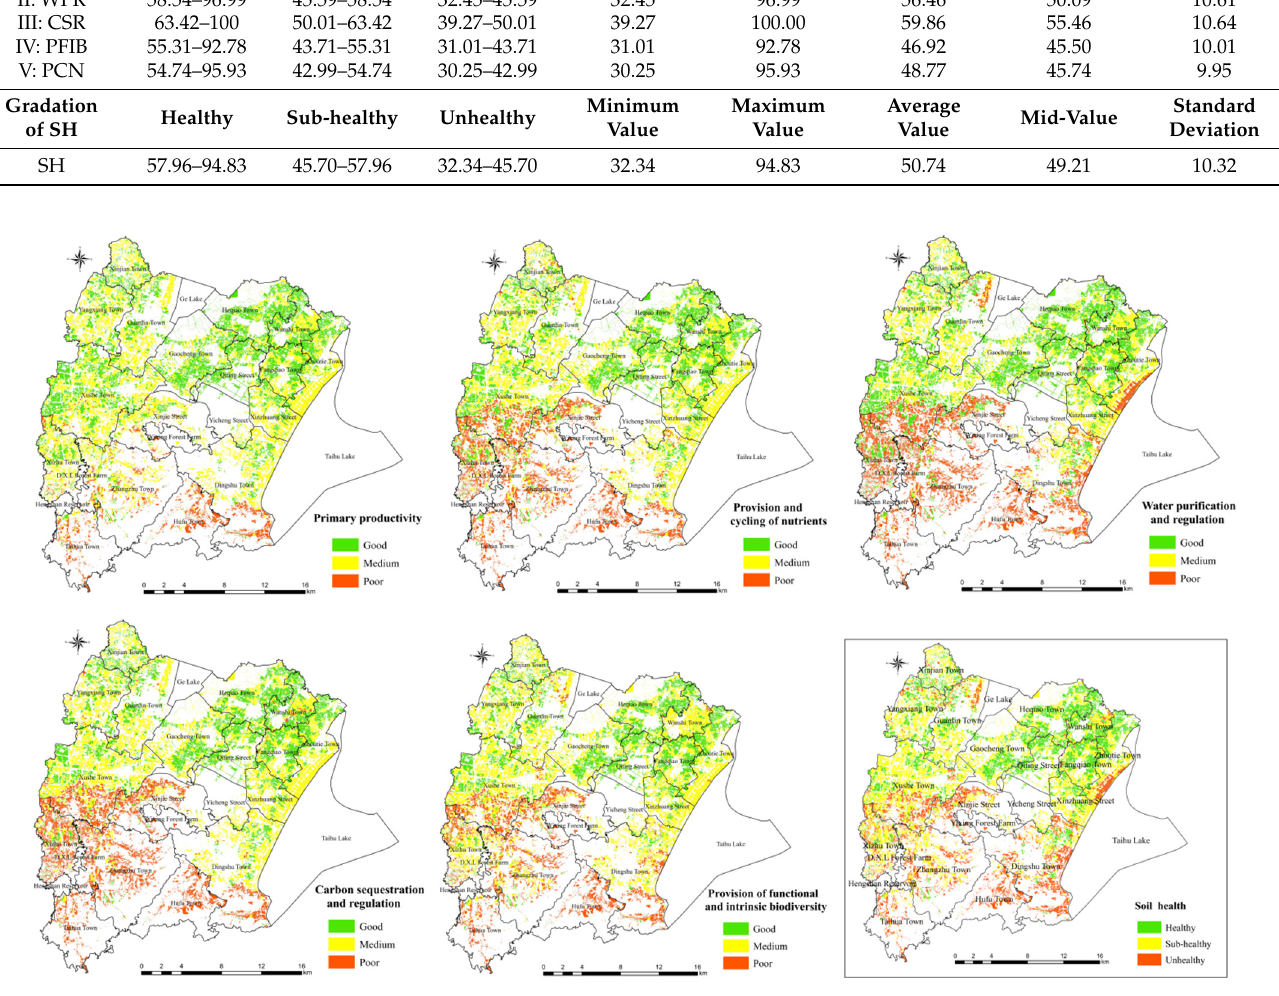
Figure 4. Spatial distribution map of SF and SH in Yixing City.